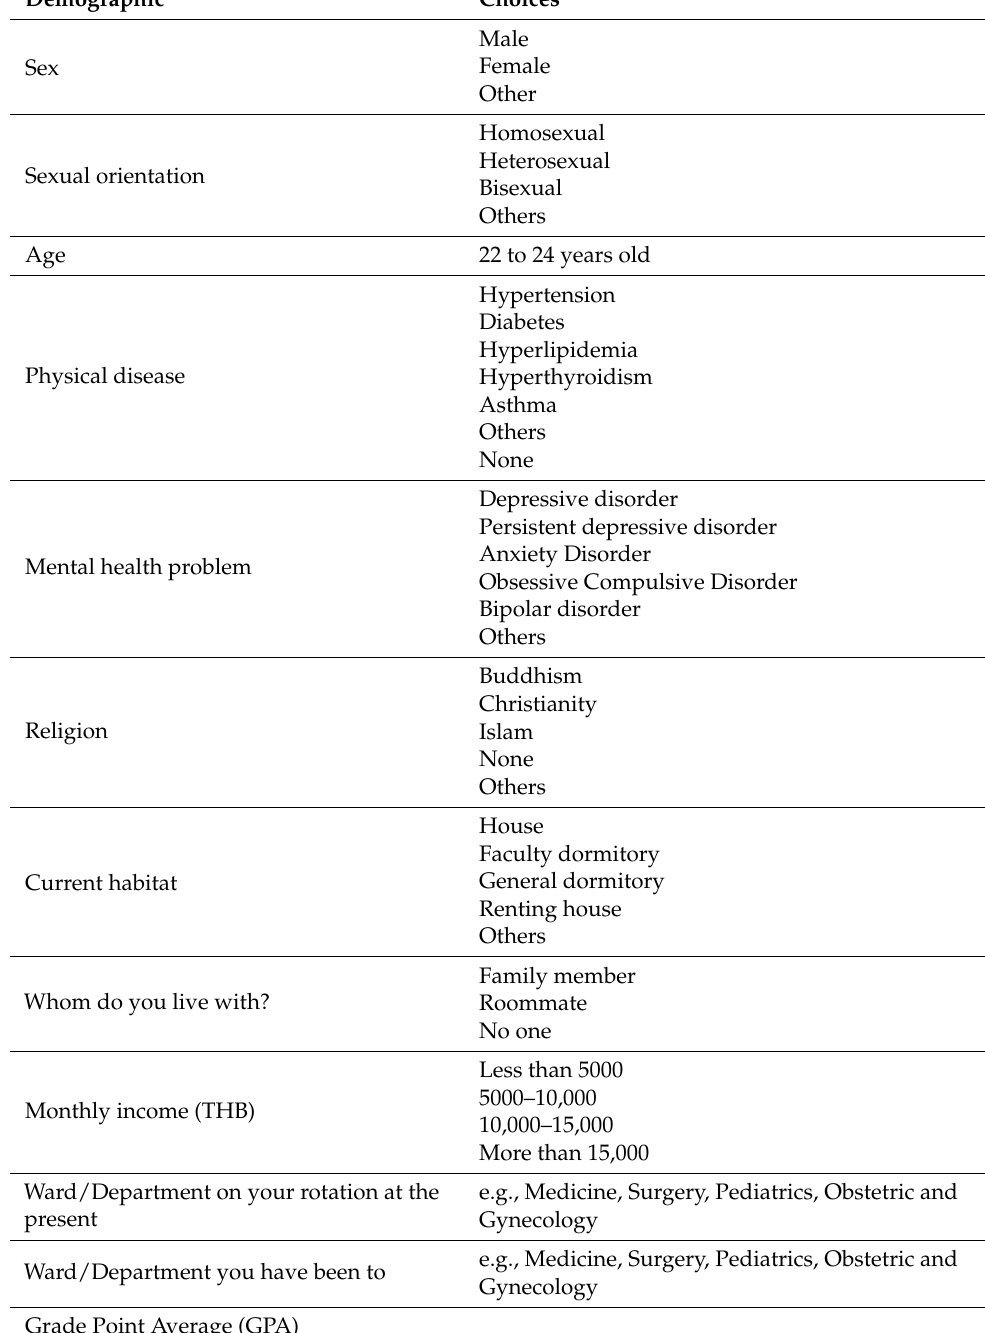
Table 1. Sociodemographic